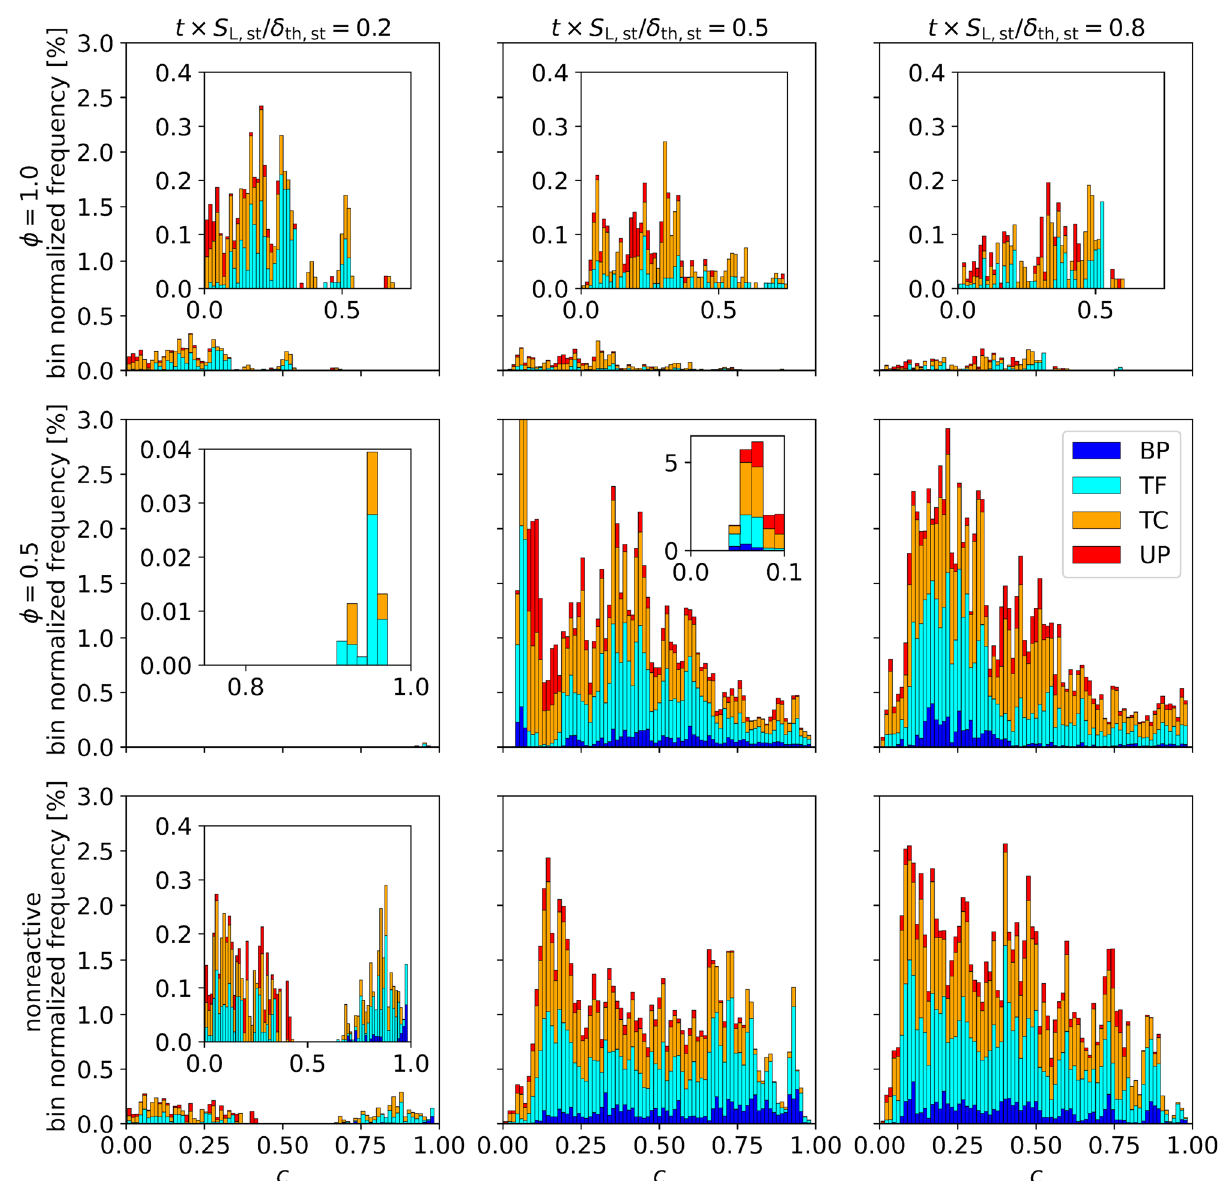
Figure 6. Histograms of the FSI topology counts (normalized with the respective bin volume) over c for the S normalized times t L,st /δ th,st = 0.2, 0.5, 0.8 (after first shock, directly and later after reshock) and the three × 1.0 , φ 0.5 and cases φ = =